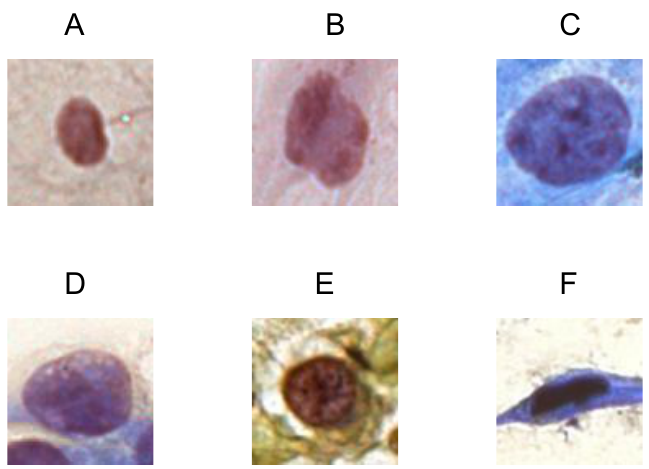
Figure 1. Example of the 90 × 90 cutouts of each class present in the Center for Recognition and Inspection of Cells (CRIC) cervix collection: ( A ) NILM; ( B ) ASC-US; ( C ) LSIL; ( D ) ASC-H; ( E ) HSIL; ( F ) SCC.